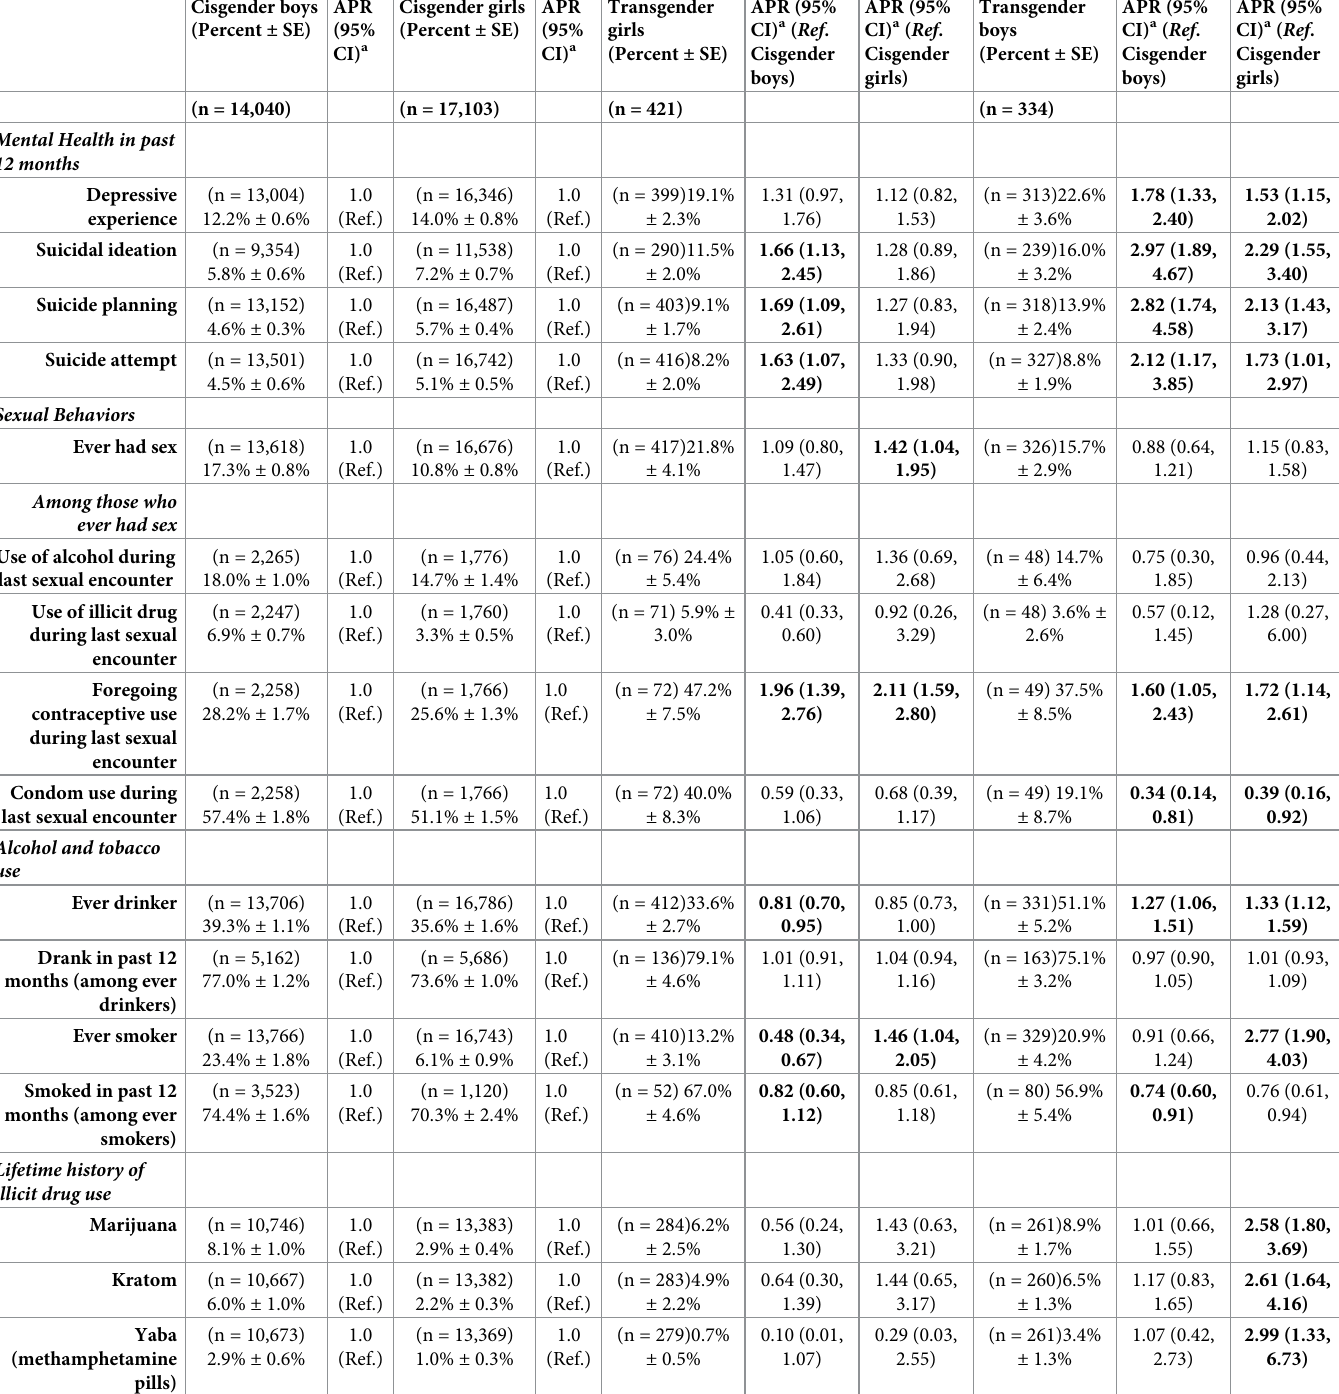
Table 3. Prevalence (weighted percent ± SE) and adjusted prevalence ratios (APRs) of mental health outcomes and health behaviors among respondents, stratified by